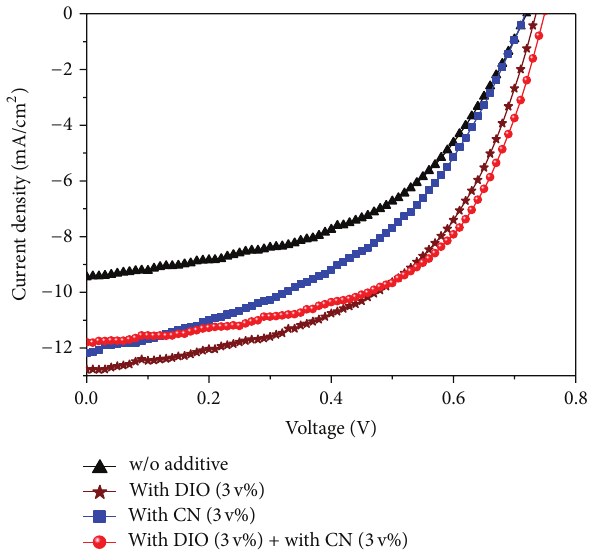
Figure 4: UV/Vis spectra of four different organic active layers of PTB7/PC 71 BM prepared with different organic solvent